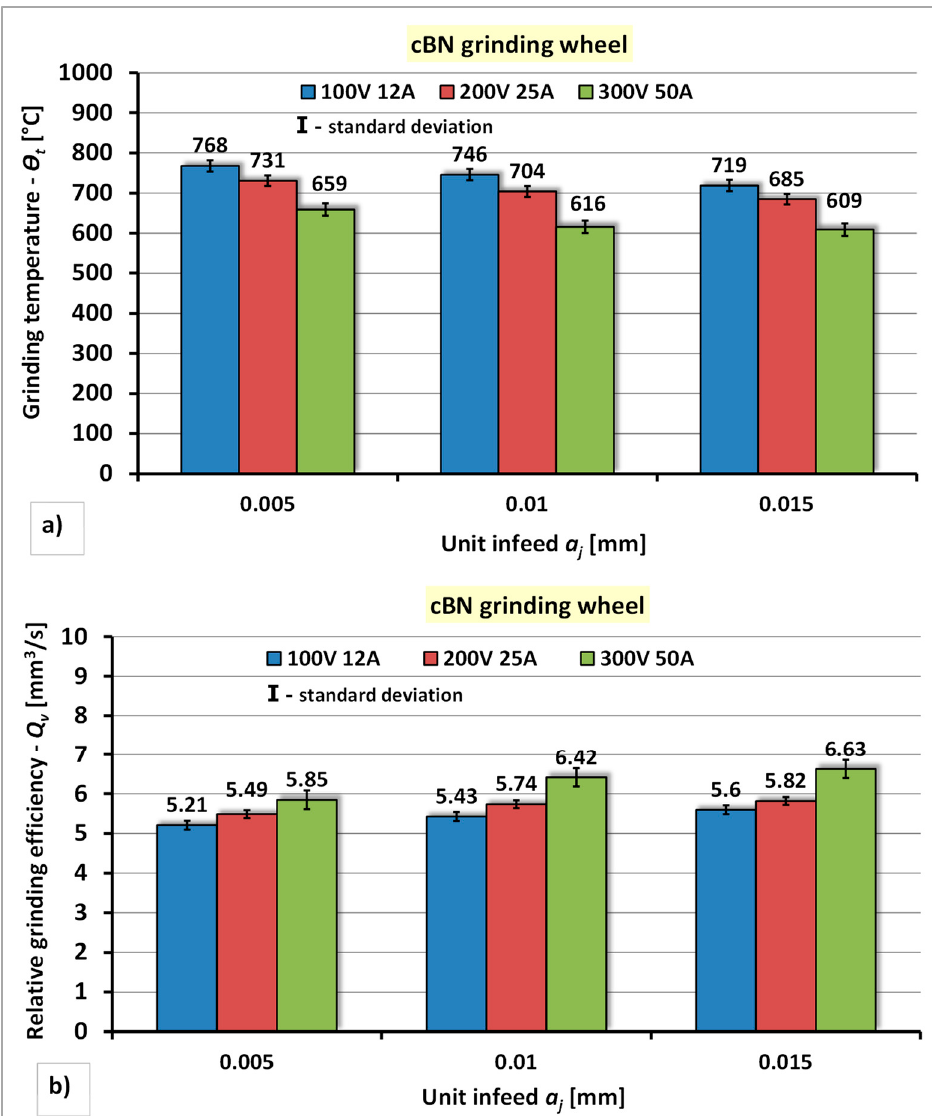
Figure 8. The effect of the generator power and unit infeed during electrodischarge dressing of a cBN grinding wheel using a stationary electrode: ( a ) On the grinding temperature— Θ t ; ( b ) On the relative grinding efficiency— Q v .